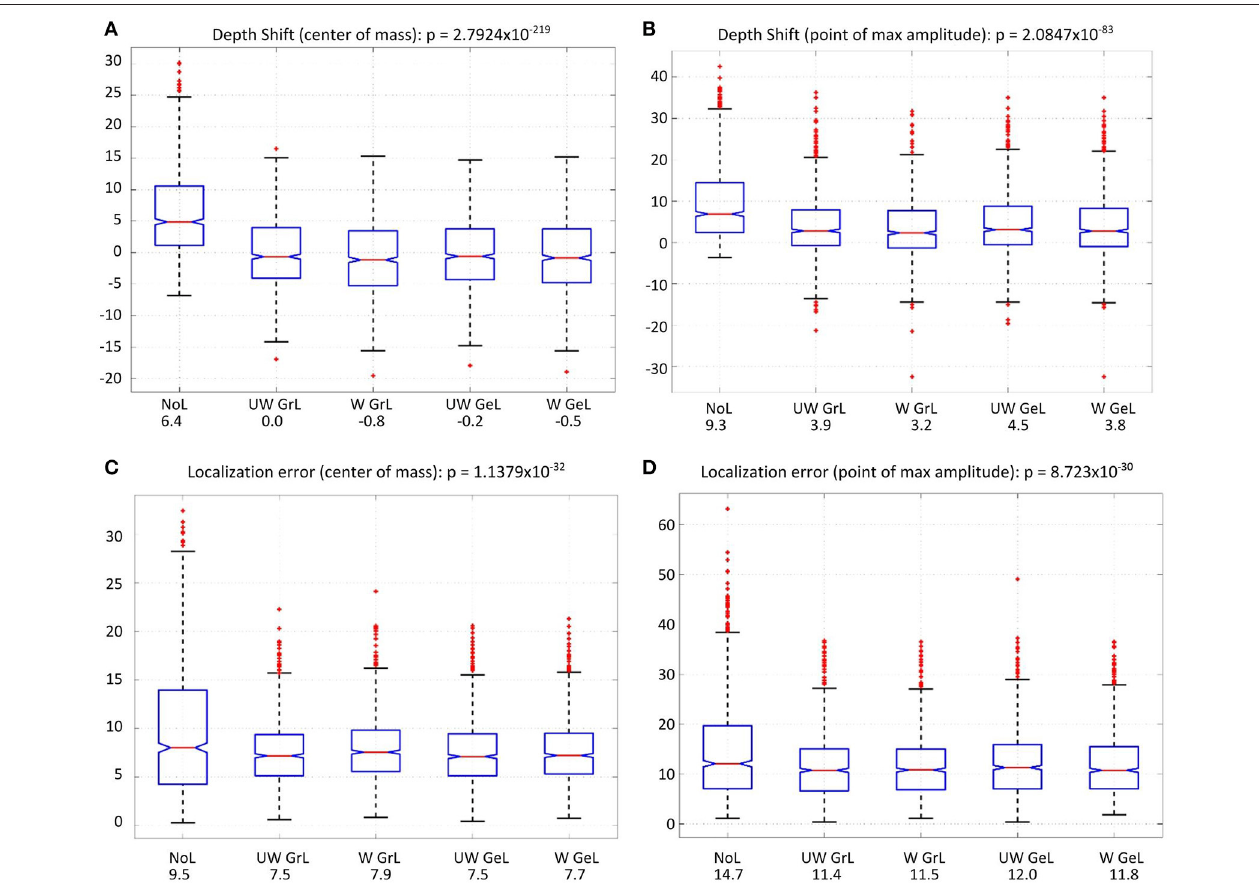
FIGURE 8 | Comparison of the depth shift [top row (A,B) ] and the localization error [bottom row (C,D) ] for all four Laplace operators and without a Laplacian (left-most). The red lines on each box mark the median, the blue boxes denote the 25th and 75th percentiles, the dashed lines extend to the most extreme data points not considering outliers; red crosses denote the outliers. The values beside the captions on the x-axis are the mean values in millimeter. (A) depth shift (center of mass), (B) depth shift (point of max amplitude), (C) localization error (center of mass), (D) localization error (point of max